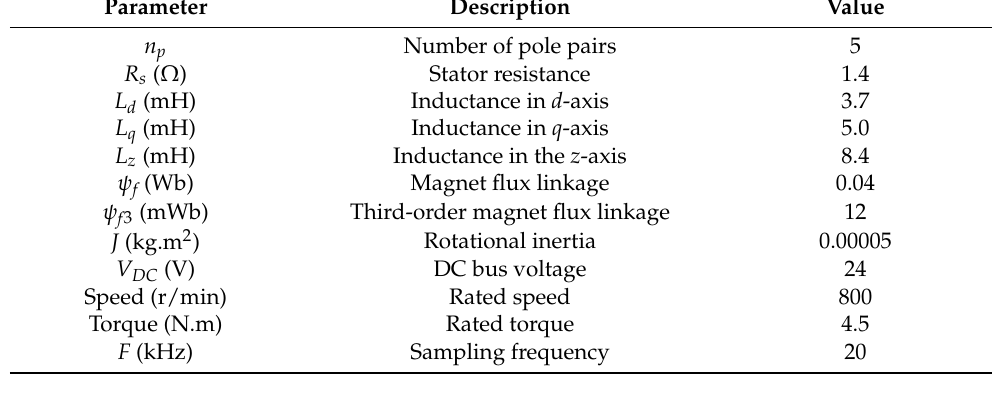
Table 1. Parameter of series-winding PMSM.